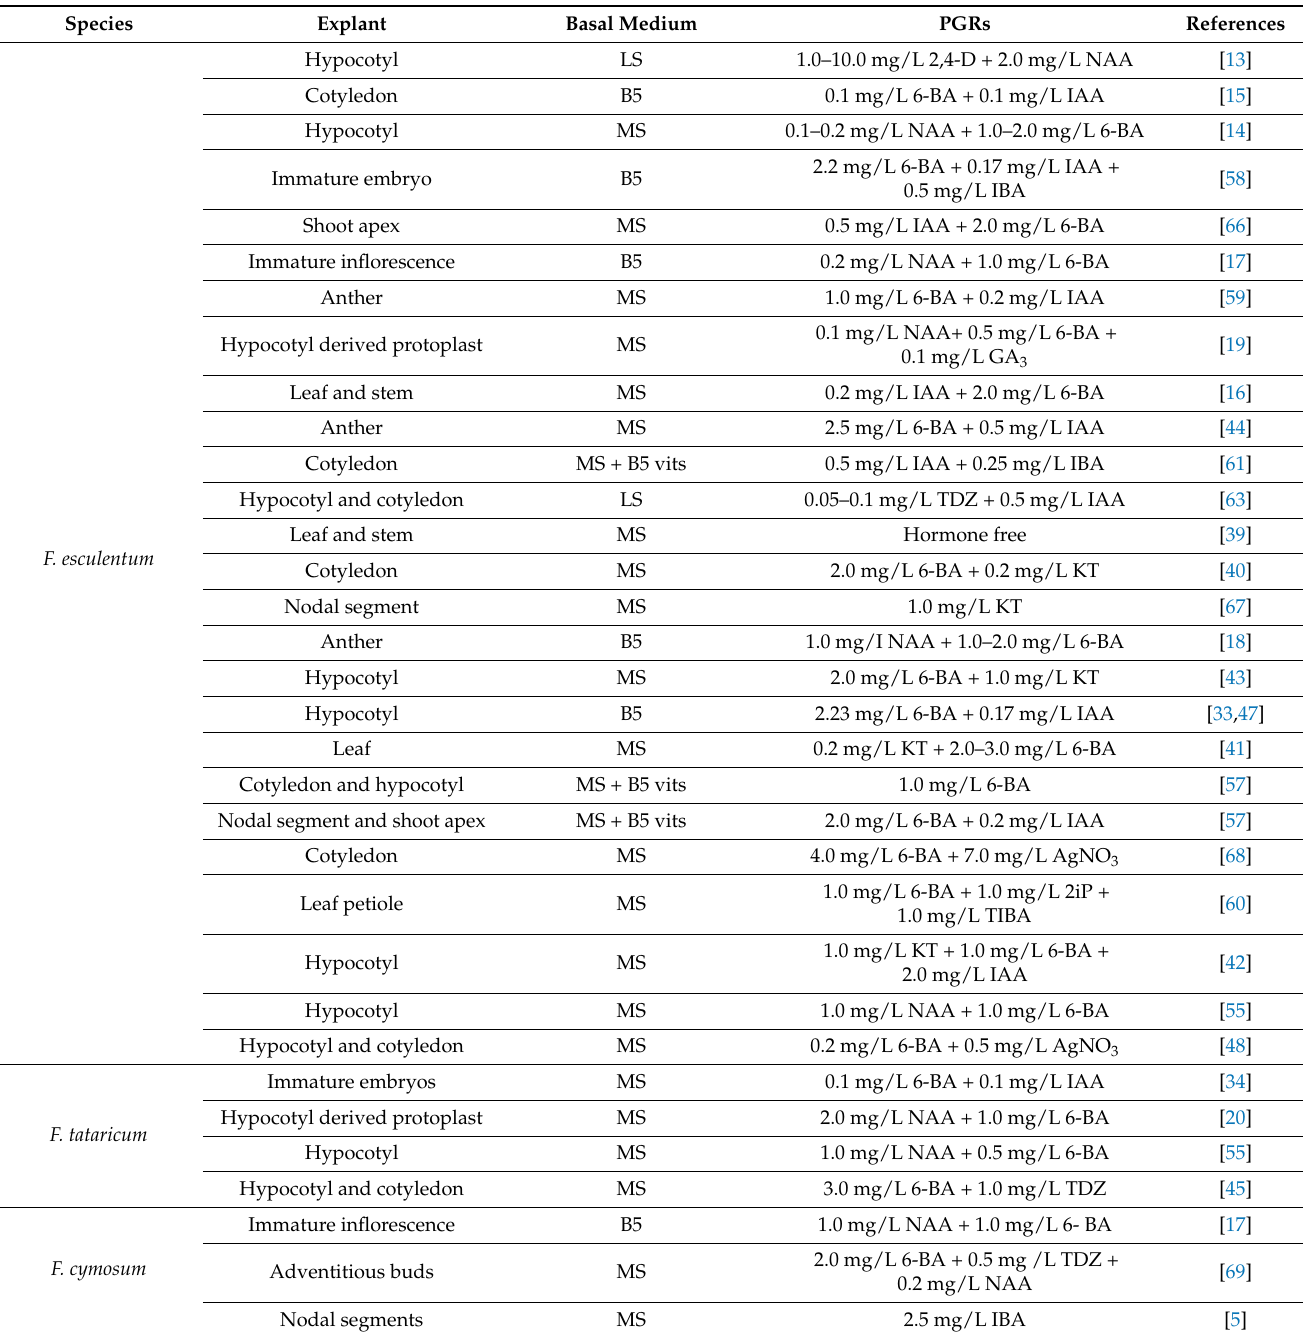
Table 2. Optimal conditions for the plantlet regeneration from different explants F. esculentum , F. tataricum and F. cymosum